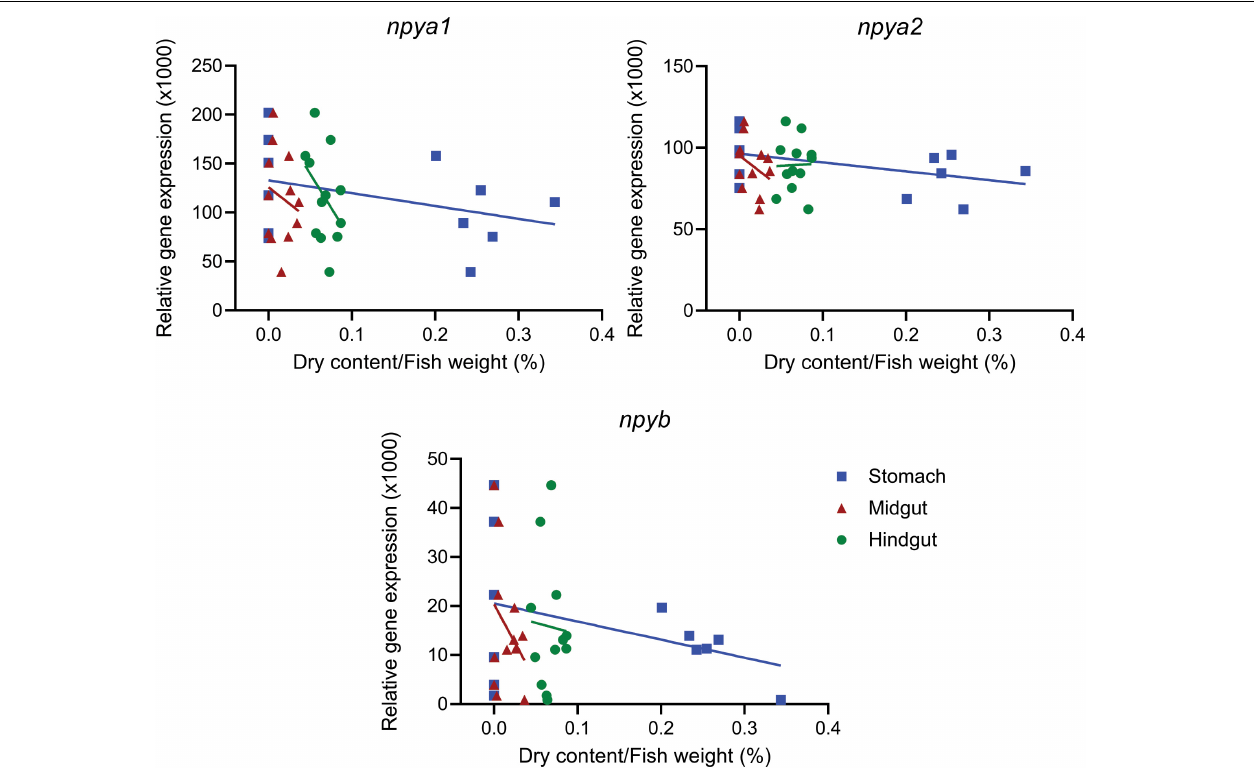
FIGURE 4 | Correlation between dry content in the gastrointestinal tract and hypothalamic expression of npya1 , npya 2, and npyb . The plots show hypothalamic mRNA expression of npya1 , npya2 and npyb versus content in the stomach, midgut and hindgut. Dots represent individual fish ( n = 12), while solid lines represent the linear regression. The dry weight of the gastrointestinal content was standardized to the fish weight. For detailed statistical information, refer to Supplementary Table 6